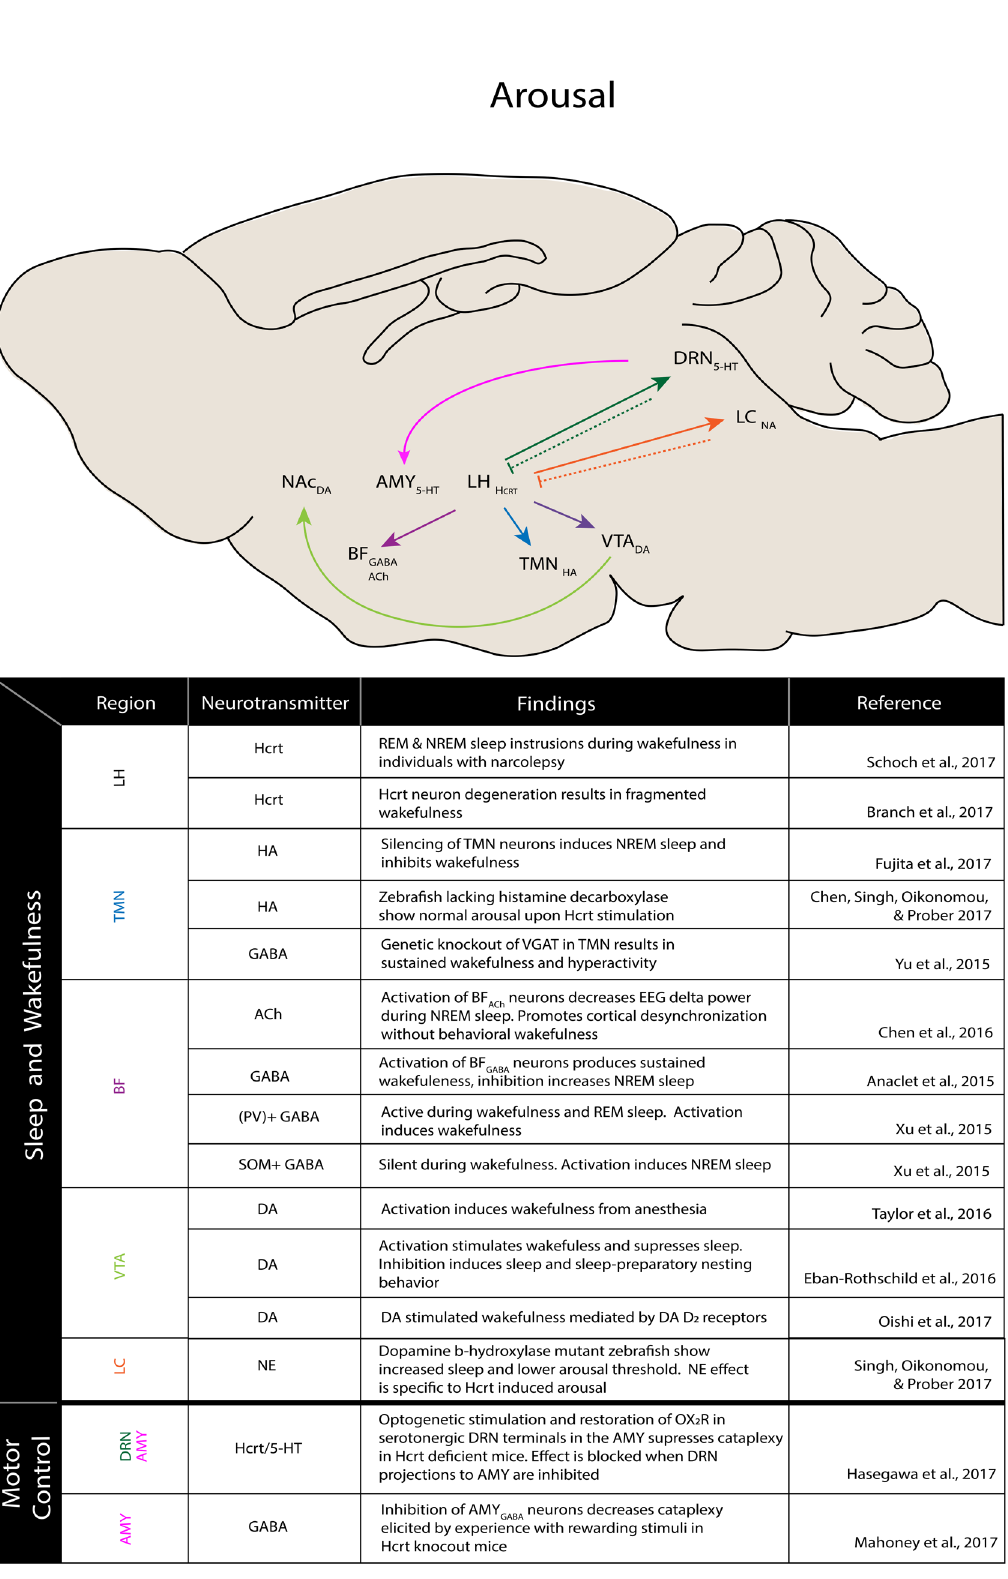
Figure 1. Hypocretin arousal network. Research of the past three years has found evidence of hypocretin-associated arousal in the illustrated circuits. Solid lines denote excitatory projections, and dashed lines denote inhibitory projections. 5-HT, serotonin; ACh, acetylcholine; AMY, amygdala; BF, basal forebrain; DA, dopamine; DRN, dorsal raphe nucleus; GABA, gamma aminobutyric acid; HA, histamine; Hcrt, hypocretin; LC, locus coeruleus; LH, lateral hypothalamus; NA, noradrenergic system; NAc, nucleus accumbens; NE, norepinephrine; NREM, non-rapid eye movement; PV, parvalbumin; REM, rapid eye movement; SOM, somatostatin; TMN, tuberomammillary nucleus; VTA, ventral tegmental